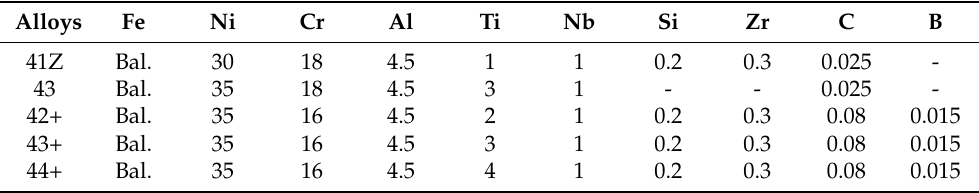
Table 1. Chemical composition in wt% for the model heat resistant